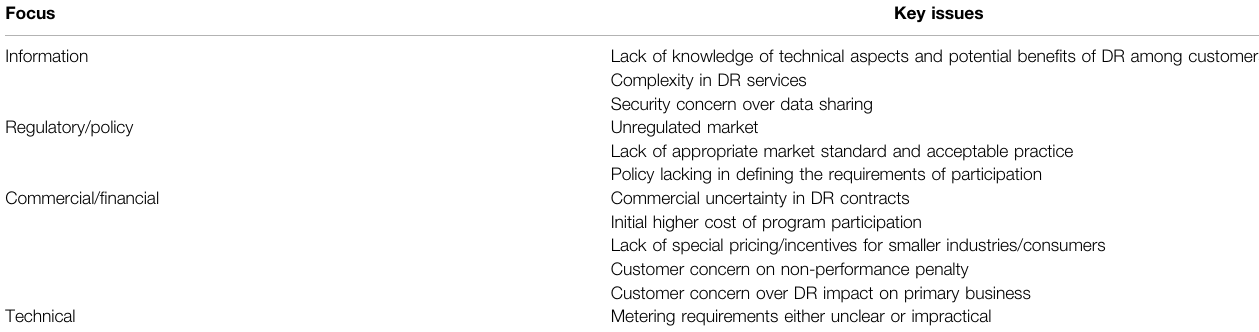
TABLE 8 | Key issues in demand response participation.